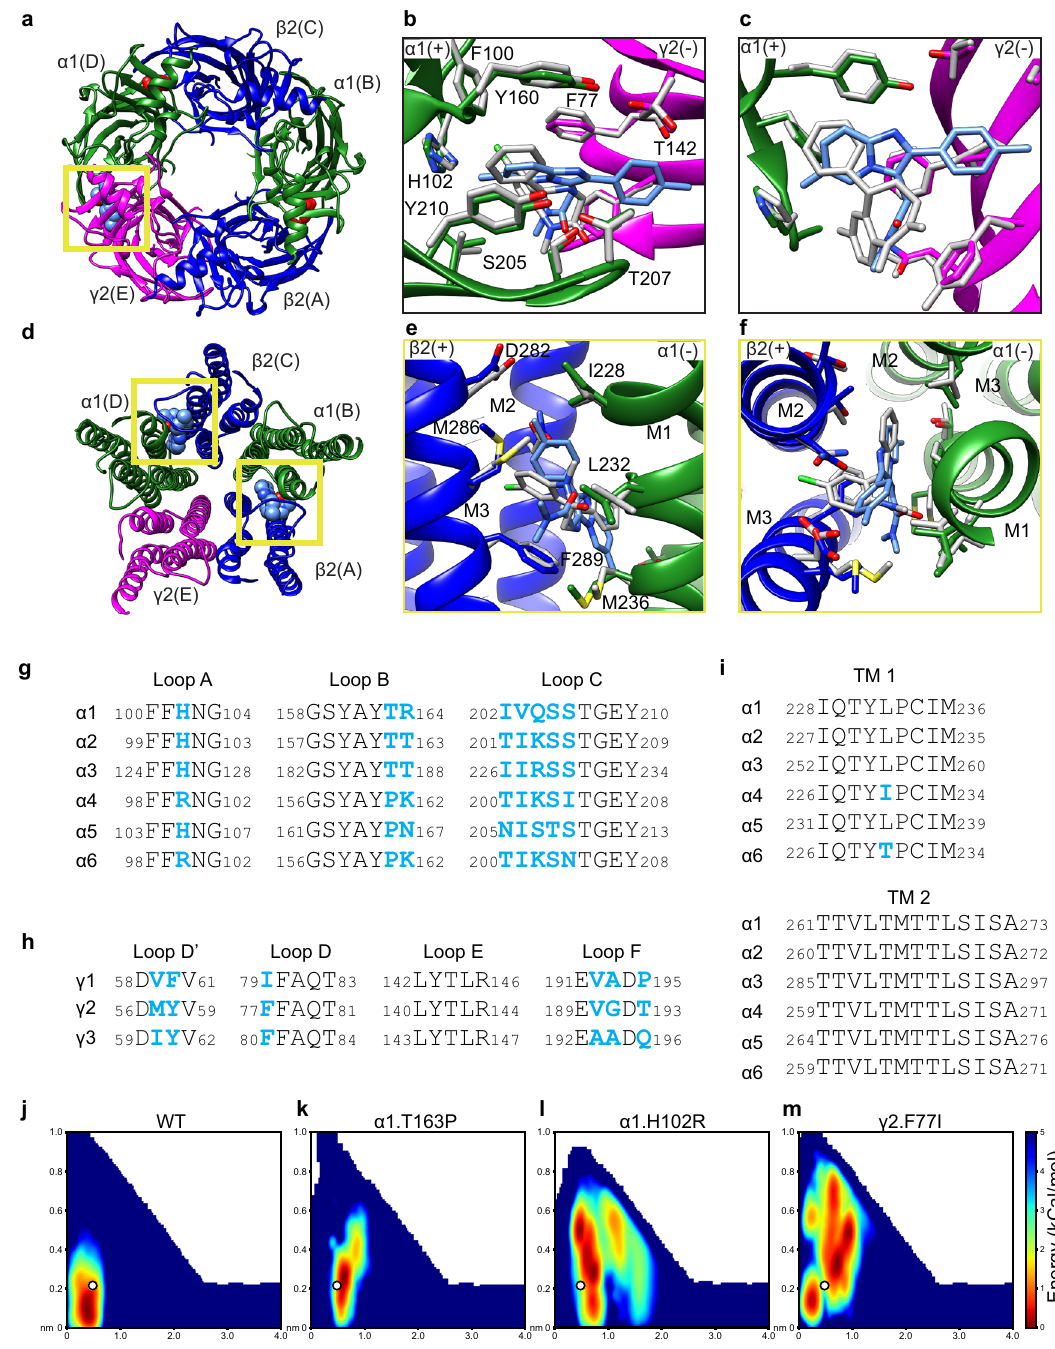
Fig. 3 | Zolpidem versus diazepam binding. a Synaptic view; yellow box indi- cates the ECD-benzodiazepine site. b , c Superposition of bound diazepam (in gray) on zolpidem-bound structure. b Synaptic view as in a . c Side view of the zolpidem binding pocket with loop C backbone hidden for clarity. d Atomic model of TMD viewed down channel axis from synaptic side; yellow boxes highlight two zolpidem binding sites with ligands shown as spheres. e , f Superposition of bound diazepam (in gray) on zolpidem-bound structure, focused on β / α interface. e , Side view as in Fig. 2g. f Synaptic view as Fig. 2h. g – i Sequence alignment of the ECD loops and TMD helices involved in ligand